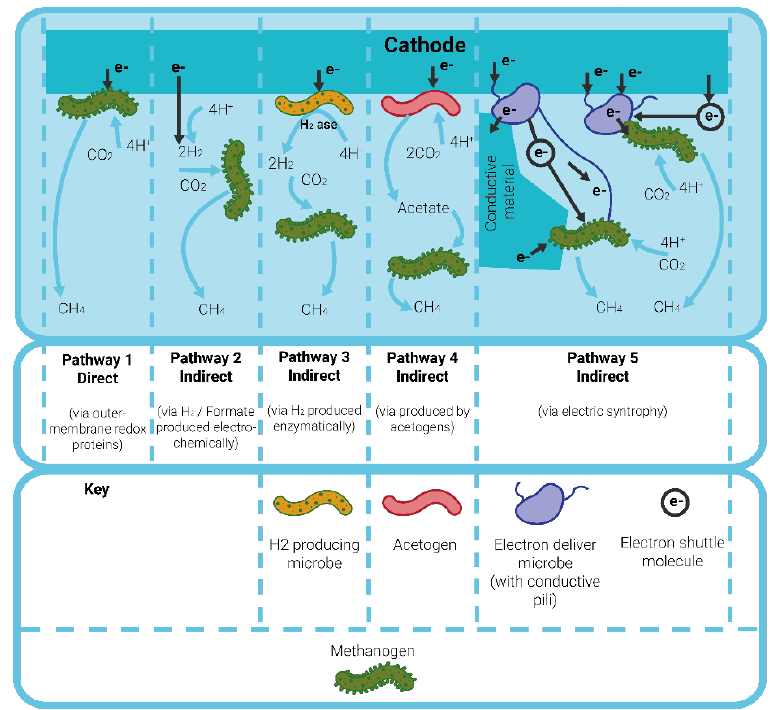
Figure 3. Schematic outlining the possible routes of methanogenesis for CH 4 production. Pathway 1: direct electron transfer, Pathway 2: indirect electron transfer via electrochemically produced H 2 , Pathway 3: indirect electron transfer via enzymatically produced H 2 , Pathway 4: indirect electron transfer via biologically produced acetate, and Pathway 5: indirect electron transfer via electric syntrophy. Schematic adapted from [20].